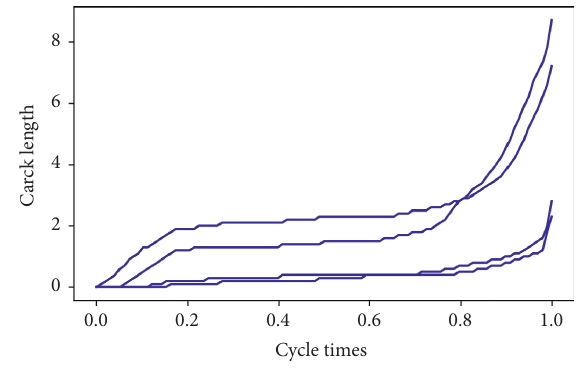
Figure 9: Normalized data of three holes with variable amplitude. dashed lines in the figure) with a width of ( ε ) centered on f ( x ) (i.e., the solid line in the figure). On the contrary, if the training samples fall into this interval, they are considered to be correctly predicted.